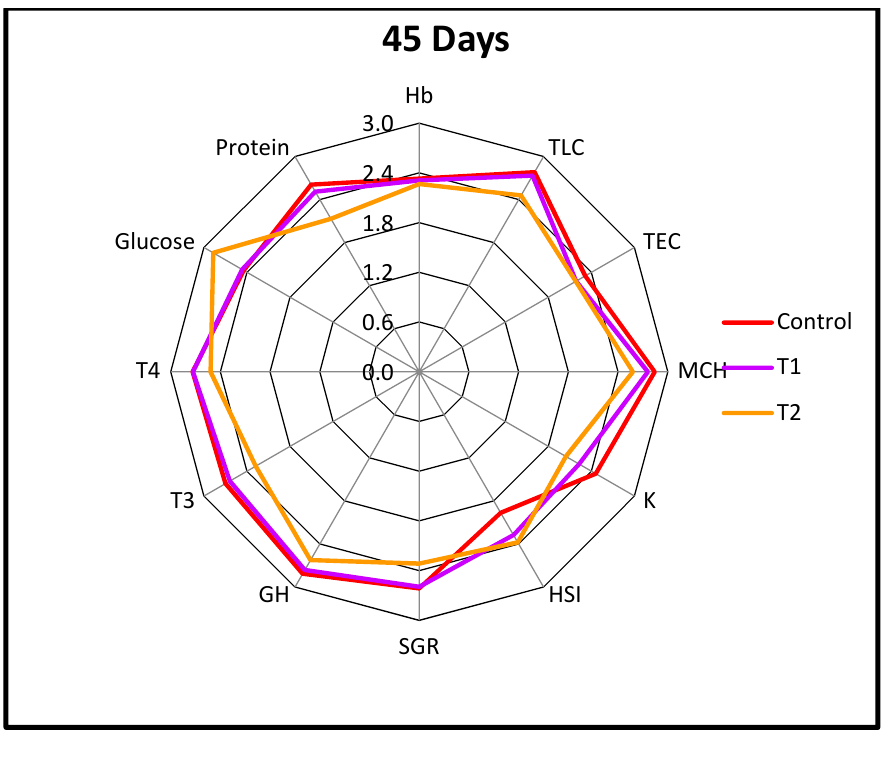
Figure 6. Star plot of the studied biomarkers in Clarias batrachus after ( a ) 15 days, ( b ) 30 days, and ( c ) 45 days diazinon exposure.